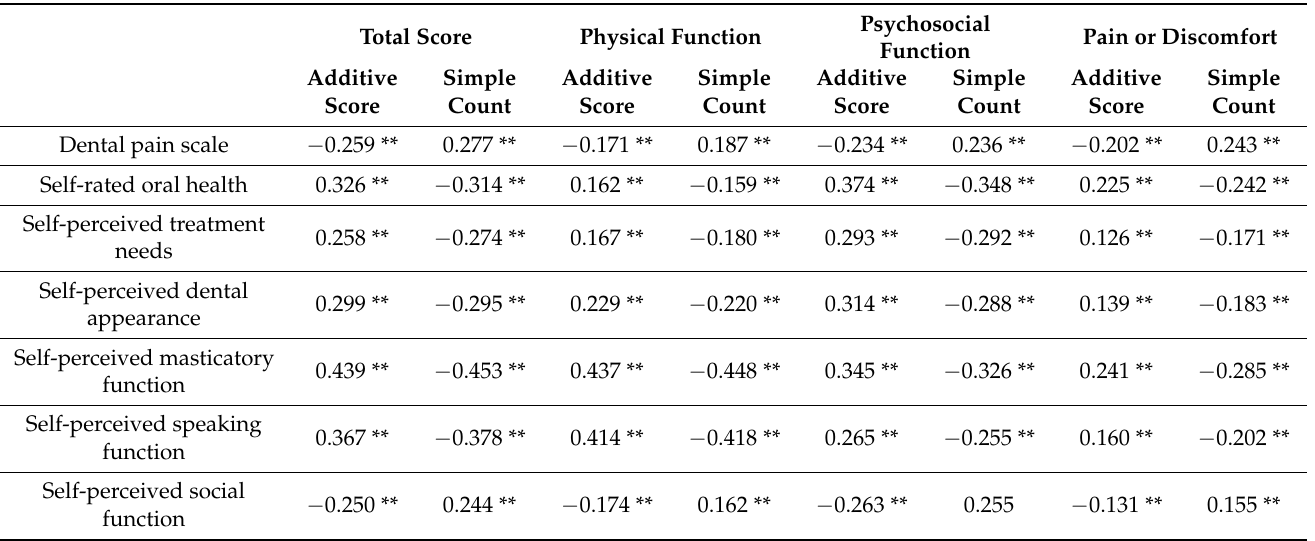
Table 4. Correlation of total score and dimension scores of GOHAI (ADD-GOHAI) with dental pain scale, self-rated oral health, self-perceived treatment needs, self-perceived dental appearance, self- perceived masticatory function, self-perceived speaking function and self-perceived social